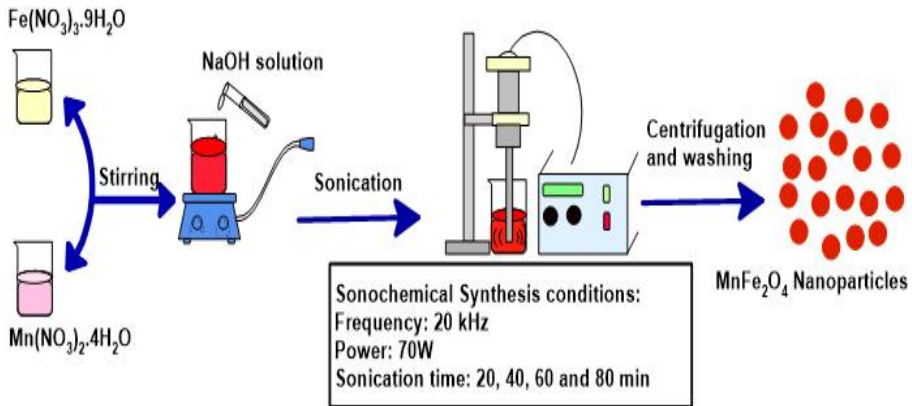
Figure 1. Schematic illustration of the preparation of MnFe 2 O 4 nanoparticles by the sonochemical synthesis method. Table 1. Synthesis condition for preparation of MnFe 2 O 4 nanoparticles by the sonochemical method.